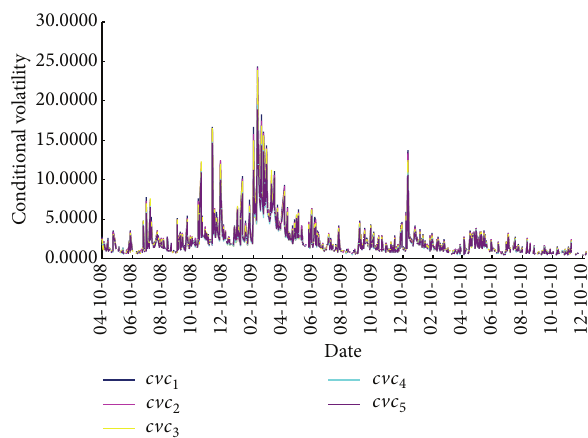
Figure 2: Conditional volatility with different maturities disturbed from futures market ( ×10 −4 ).